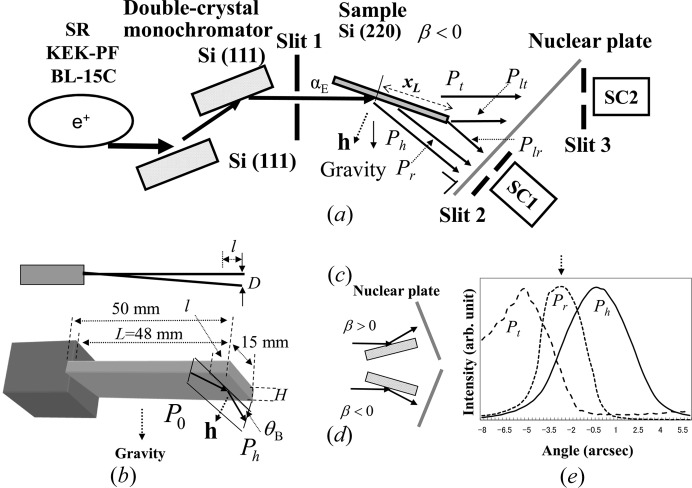
(a) A schematic diagram of the measuring system. xL is the distance between the incident point of the X-rays and the crystal edge of the entrance surface. SC1 and SC2 are the scintillation counters set up in the reflected- and transmitted-wave directions, respectively. (b) Sample geometries. (c) and (d) the incident- and reflected-wave geometries with respect to the samples for β > 0 and β < 0, respectively. (e) The measured rocking curves of P
h, P
t and P
r.